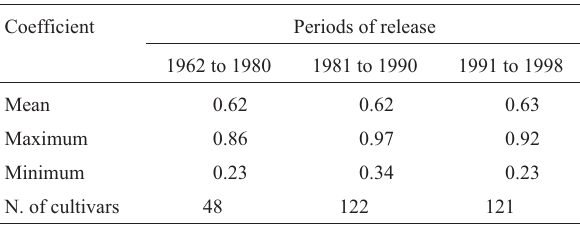
Table 3 - Mean, maximum and minimum genetic similarity coefficients (GS) for soybean cultivars released during different periods in